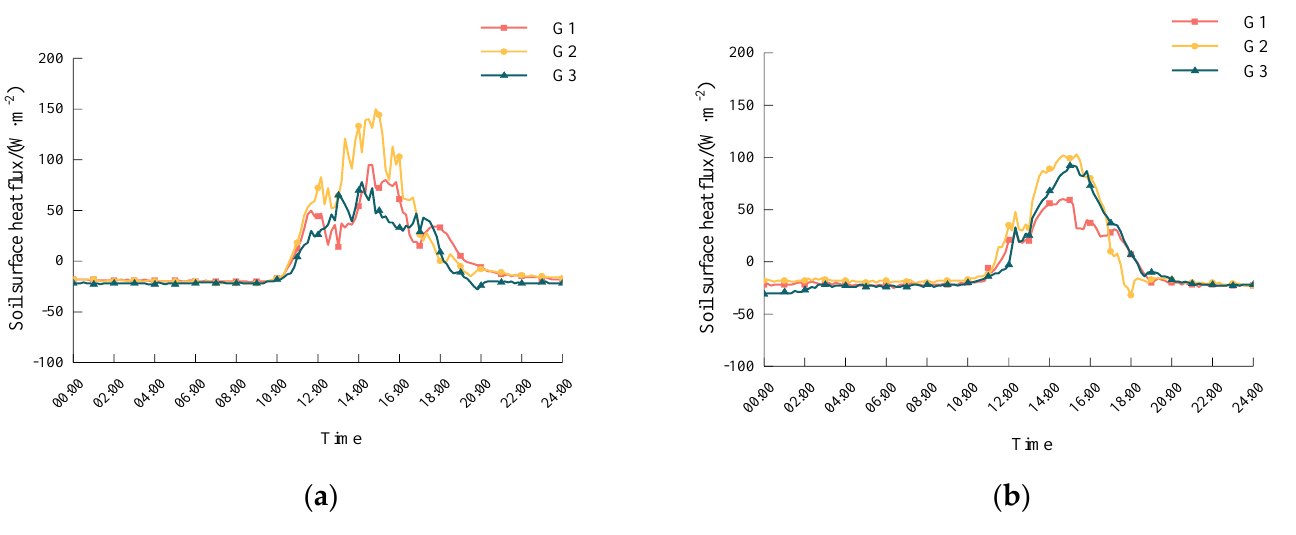
Figure 10. Variation of soil surface heat flux in typical weather in CSGs. ( a ) Sunny day (20 February 2022). ( b ) Cloudy day (18 February 2022).